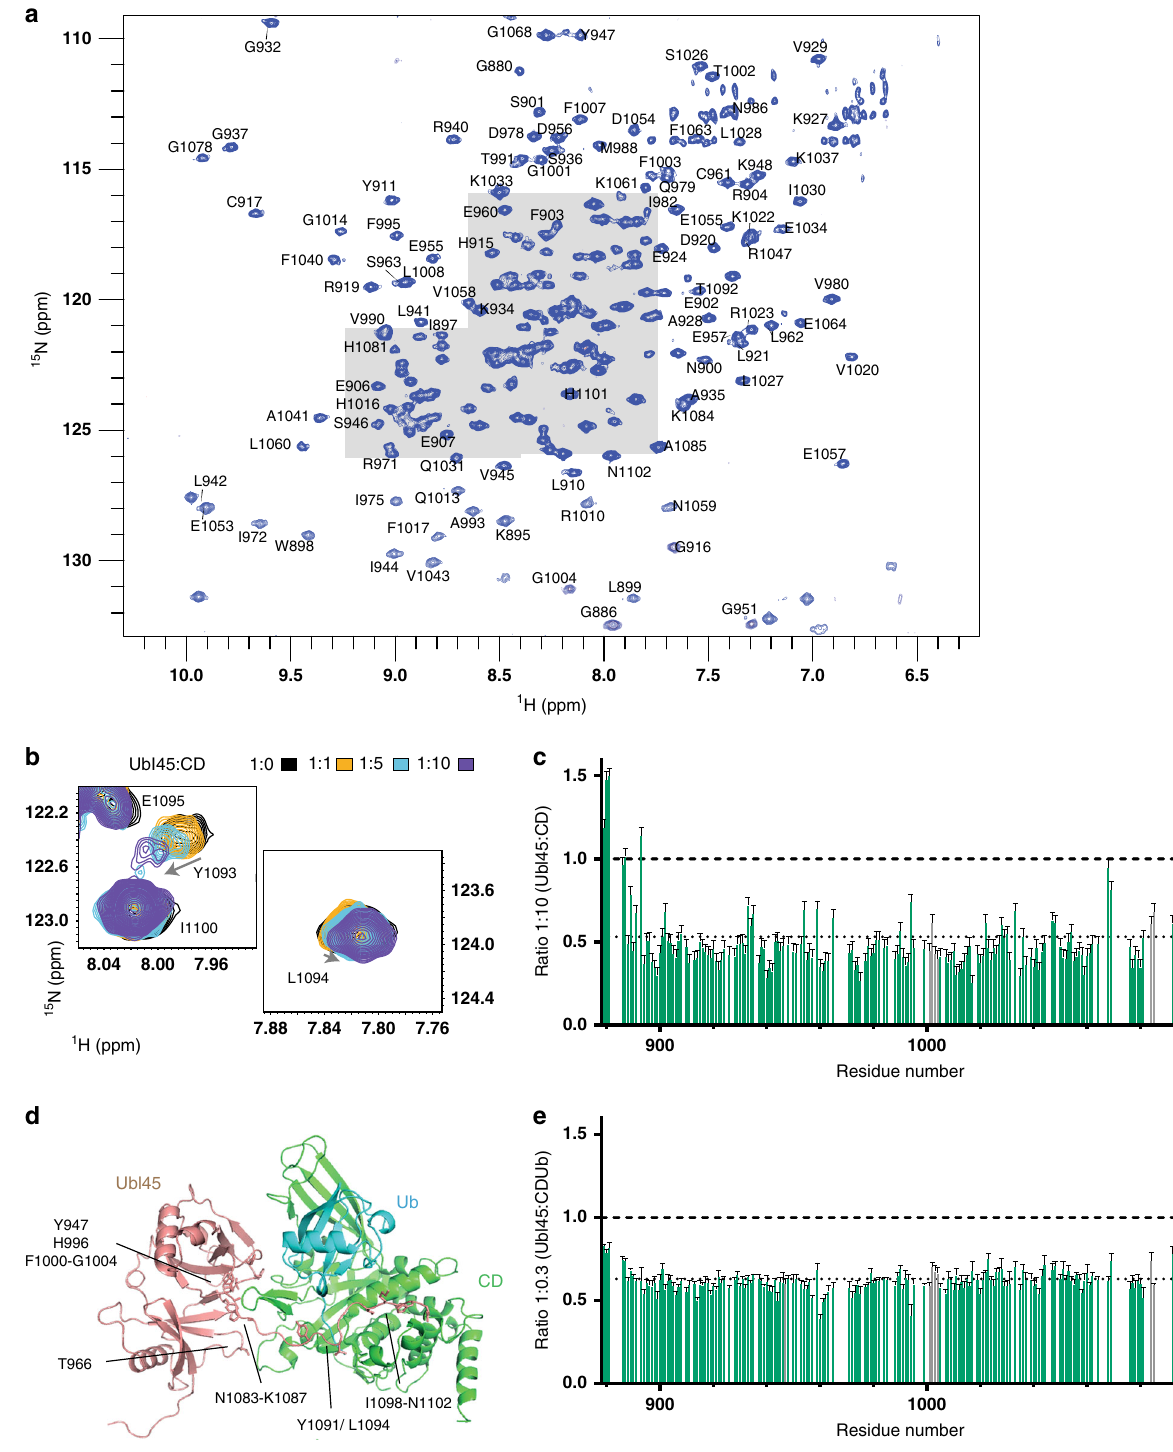
Fig. 2 Interaction between Ubl45 and CD identi fi ed in solution using NMR. a The peak dispersion and resolution in the 1 H – 15 N correlation spectrum of Ubl45 (45 µ M; 25 kDa; coloured blue) indicates a well-folded protein. Assignments are indicated, those for the crowded regions, indicated in grey, are shown in Supplementary Figure 1a. b The addition of 450 µ M CD prompted very little chemical shift perturbations (CSPs). The biggest observed CSP of 0.019 ppm for Y1093 is illustrated in this zoom. c Upon titration of CD the peaks in the Ubl45 spectrum shows signi fi cant decrease in intensity. Here the intensity ratios between the apo spectrum (1:0) and the highest titration (1:10) are plotted against the residue numbers. The average is indicated by a dotted line, while residues that were found in the crystal structure to interact ( d ) are highlighted in the bar graph. d Structure and intermolecular interface in the Ubl45-CDUb structure (PDB: 5JTV 36 ), showing contacts between both the tail and the core of Ubl45 to CD. Ubl45 residues that are within 4 Å of CD are shown as sticks and indicated. e The same intensity plot as in c , but now done for the titration with CDUb indicates that the tail now does get immobilised. For c and e , the bars are normalised against the overall intensity of all peaks of the apo